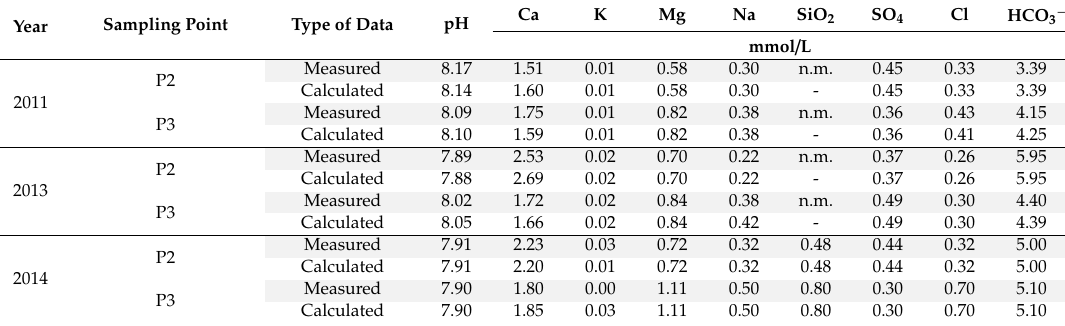
Table 4. Comparison between the measured concentrations of the main ions and the calculated from the model; n.m.: not